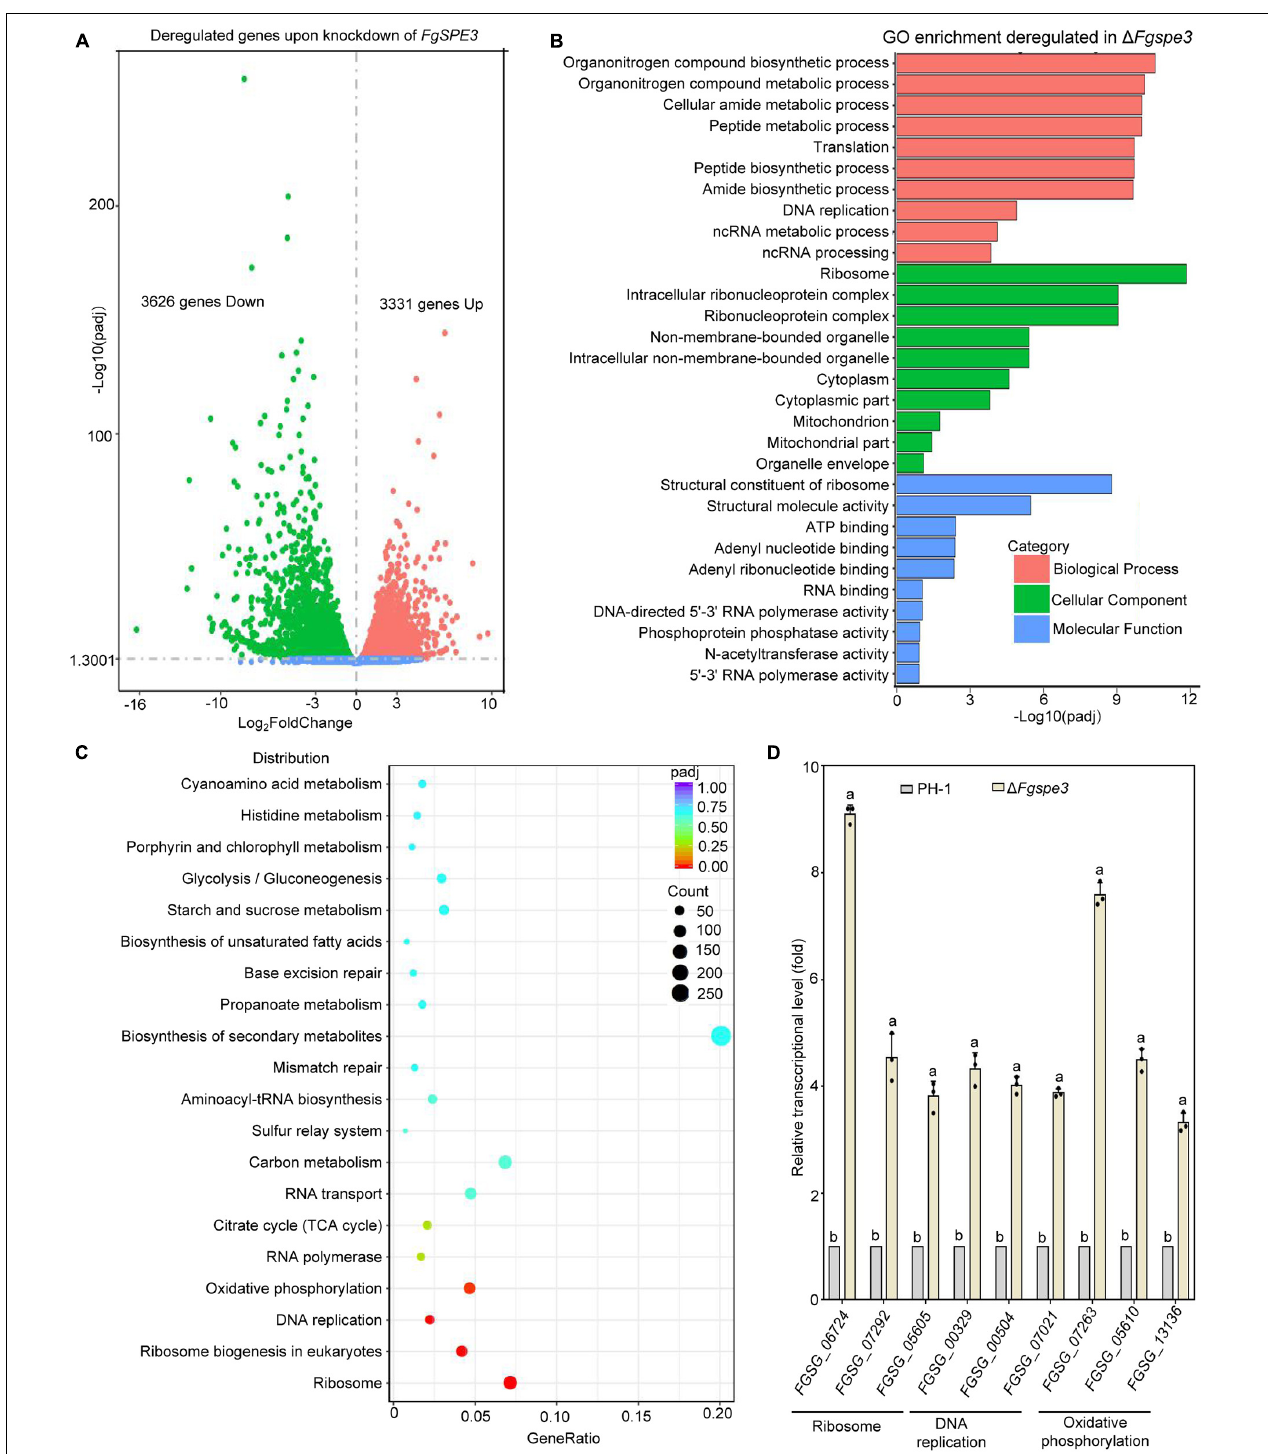
FIGURE 9 | Transcriptomic analyses between (cid:49) Fgspe3 and the wild-type PH-1. (A) Volcano plot analysis of differentially expressed genes (DEGs) of (cid:49) Fgspe3 . The x -axis shows the log2fold-change in RNA expression between PH-1 and (cid:49) Fgspe3 , while the y -axis indicates the –log10 of the adjusted P -value for each RNA, The P -values were adjusted using Benjamini–Hochberg multiple testing. The red dots and green dots represent upregulated and downregulated DEGs. (B) Gene Ontology (GO) term enrichment analysis of DEGs of (cid:49) Fgspe3 . (C) Kyoto Encyclopedia of Genes and Genomes (KEGG) pathway enrichment analysis of DEGs of (cid:49) Fgspe3 . (D) Expression levels of selected genes were detected by RT-qPCR to PH-1 and (cid:49) Fgspe3 mutant strains in YEPD medium for 48 h. Results are shown relative to PH-1 and are normalized to the housekeeping gene ACTIN . Columns listed with the same letter are not significantly different at P = 0.05.